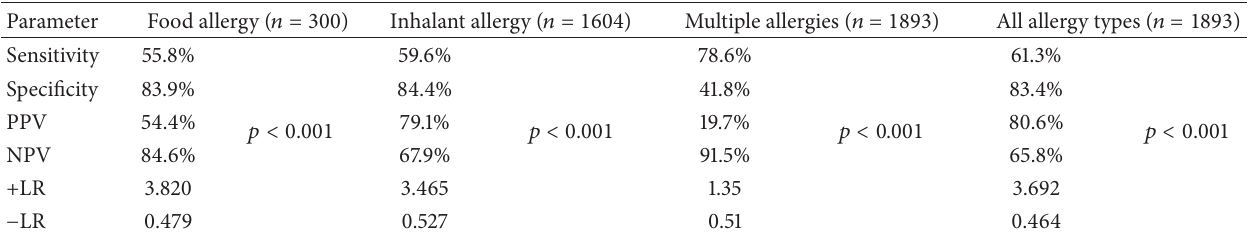
Table 2: Diagnostic value of total IgE (positive if > 195IU/mL) in food, inhalant, and multiple